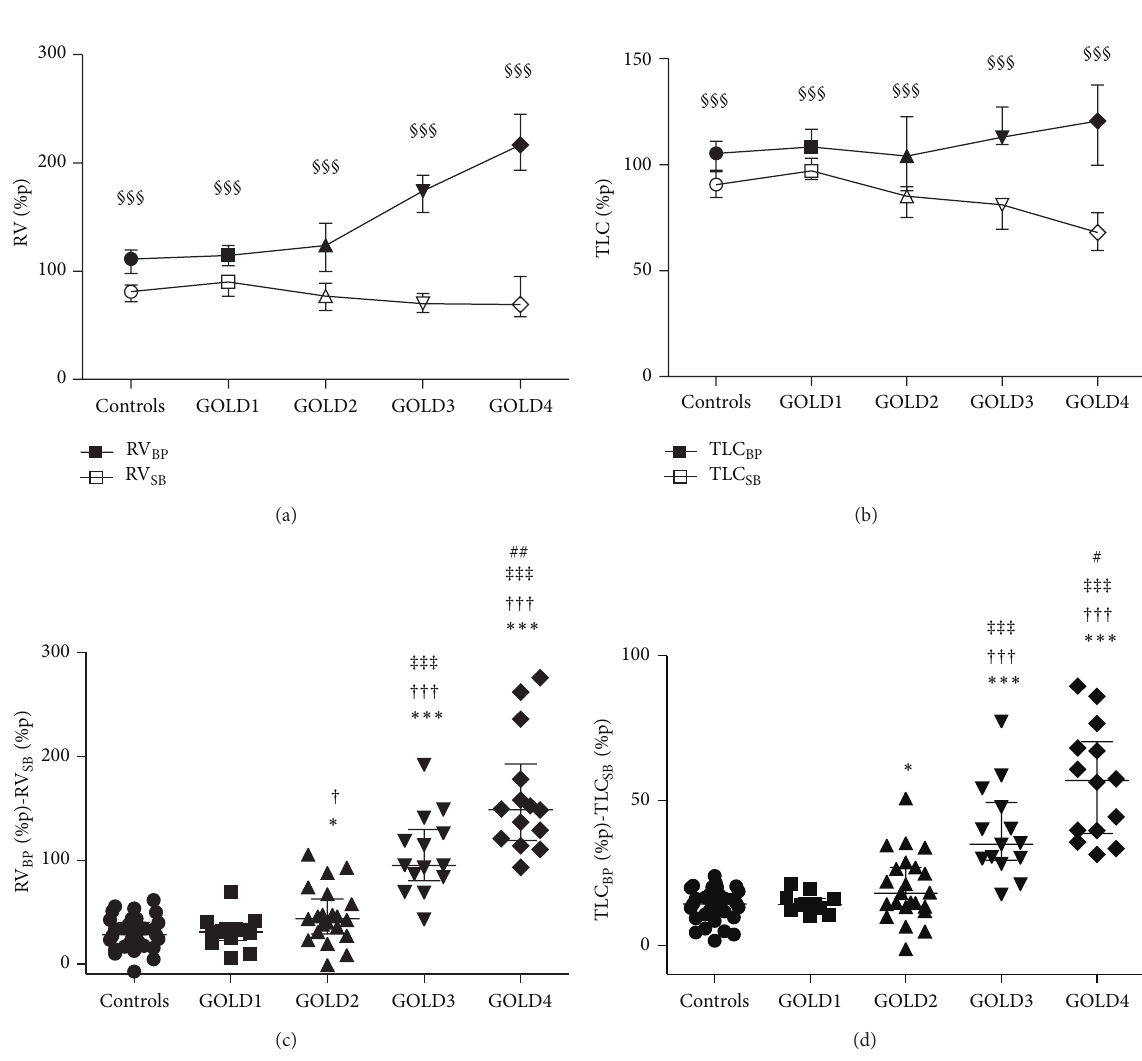
Figure 3: RV% (a) and TLC%p (b) measured by body plethysmography and single breath helium dilution with CO-diffusion. Difference ) (c) and TLC% (TLC%p ) (d) measured by body plethysmography and single breath helium dilution with CO- in RV% (RV%p BP − SB BP − SB diffusion in controls (healthy smokers) and COPD patients with GOLD stage 1–4. ∗ Significant difference compared to healthy smokers, † significant difference compared to GOLD1, ‡ significant difference compared to GOLD2, # significant difference compared to GOLD3; § significant difference between measurement from body plethysmography compared to single breath helium dilution with CO-diffusion, one symbol flagging 𝑃 < 0.05 , two symbols flagging 𝑃 < 0.01 , and three symbols flagging 𝑃 < 0.001 . Data are presented as median (IQR) in (a)-(b) and individual dots together with median with interquartile range